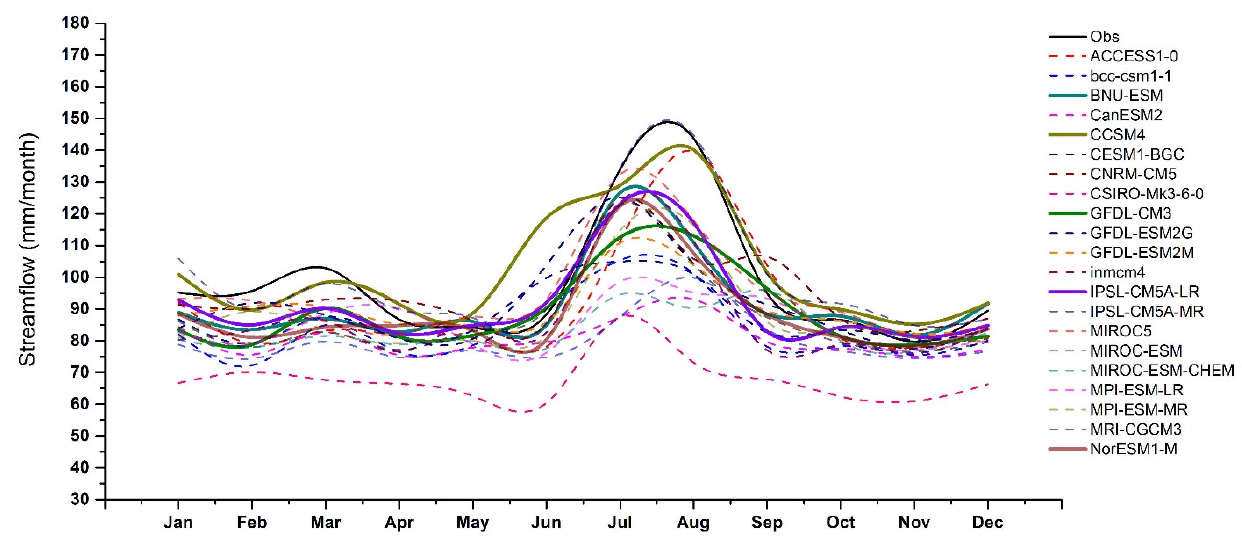
Figure 6. Monthly streamflow simulated by the HBV-light model in the Dhoke Pathan sub catchment for 1980–2004 by using observed (gauge-based, in black) and GCM (NEX-GDDP, in colors) climate inputs.